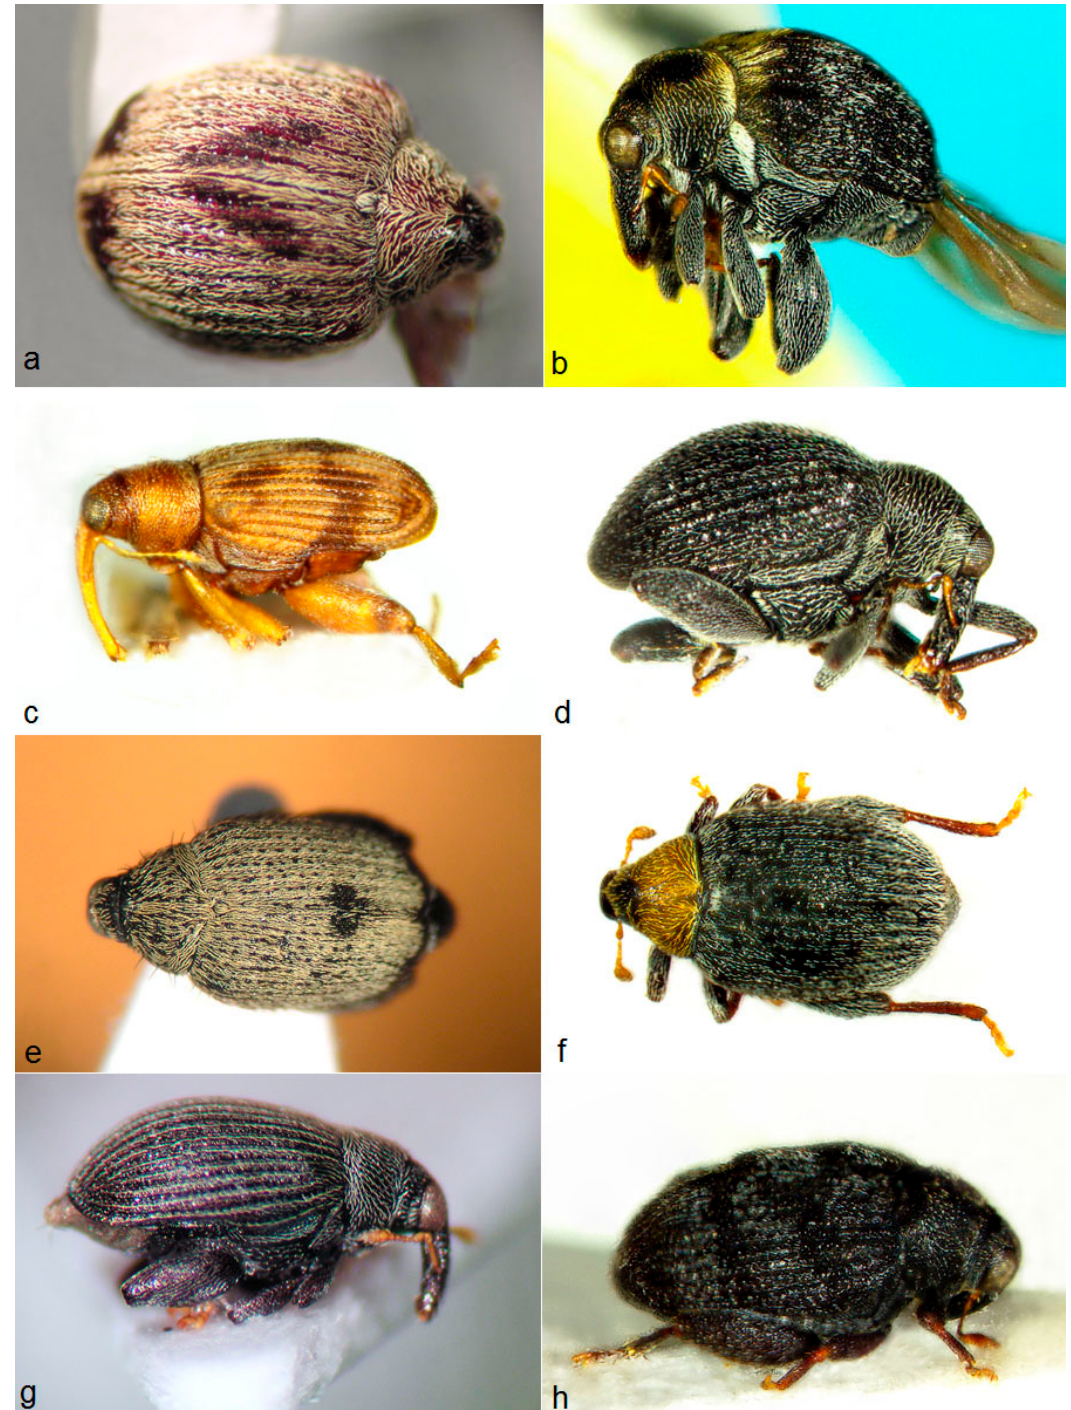
Figure 6. Curculioninae III. Rhamphini. Sphaerorchestes sp. ( a ); Imachra siamensis ( b ); Indodinorrhopalus sp. ( c ); Morimotonomizo sp. ( d ); Orchestes ( Orchestes ) sp. ( e ); Orchestes ( Nomizo ) sp. ( f ); and two unknown and probably new genera ( g , h ).